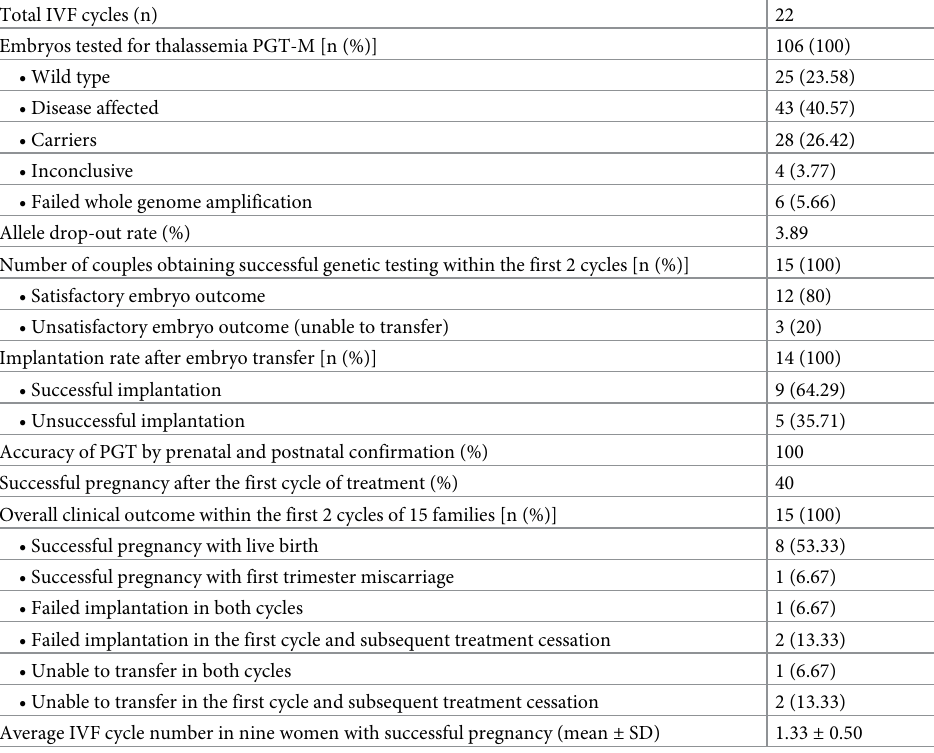
Table 4. Summary of clinical outcome in sixteen families requested for preimplantation genetic diagnosis for beta thalassemia/hemoglobin E disease in fifteen families. Total IVF cycles (n)